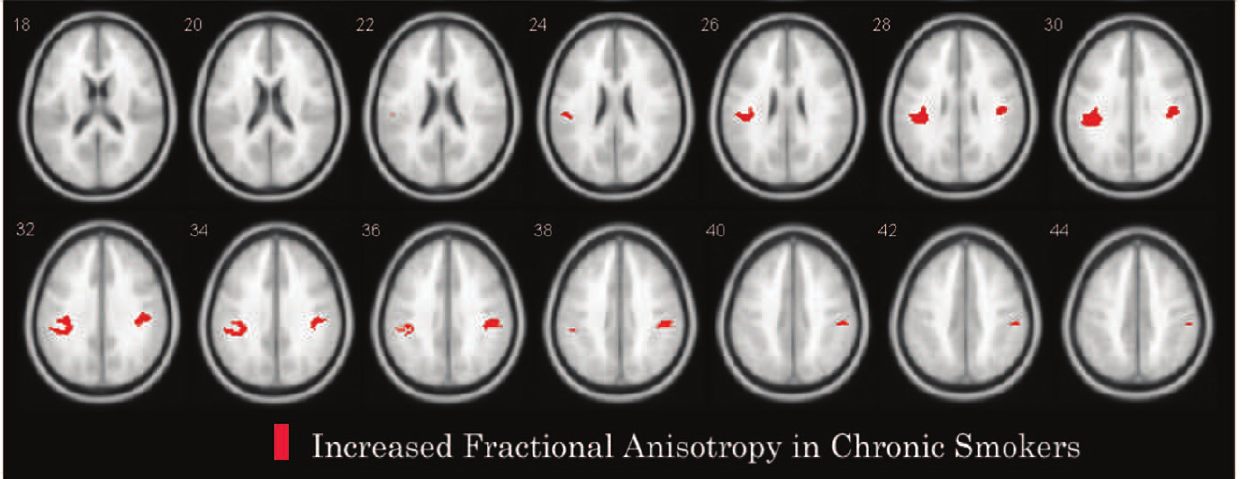
Figure 1. Clusters of increased fractional anisotropy (FA) in smokers compared to healthy non-smokers. Significant FA alterations as revealed by voxel-based whole brain analysis with SPM5 displayed on the FA average map of the sample. Voxels of increased FA in smokers revealed by SPM5 analysis are displayed with red colour. All clusters shown exceed an uncorrected statistical threshold of P , 0.001 and a cluster size threshold of 100 consecutive voxels.